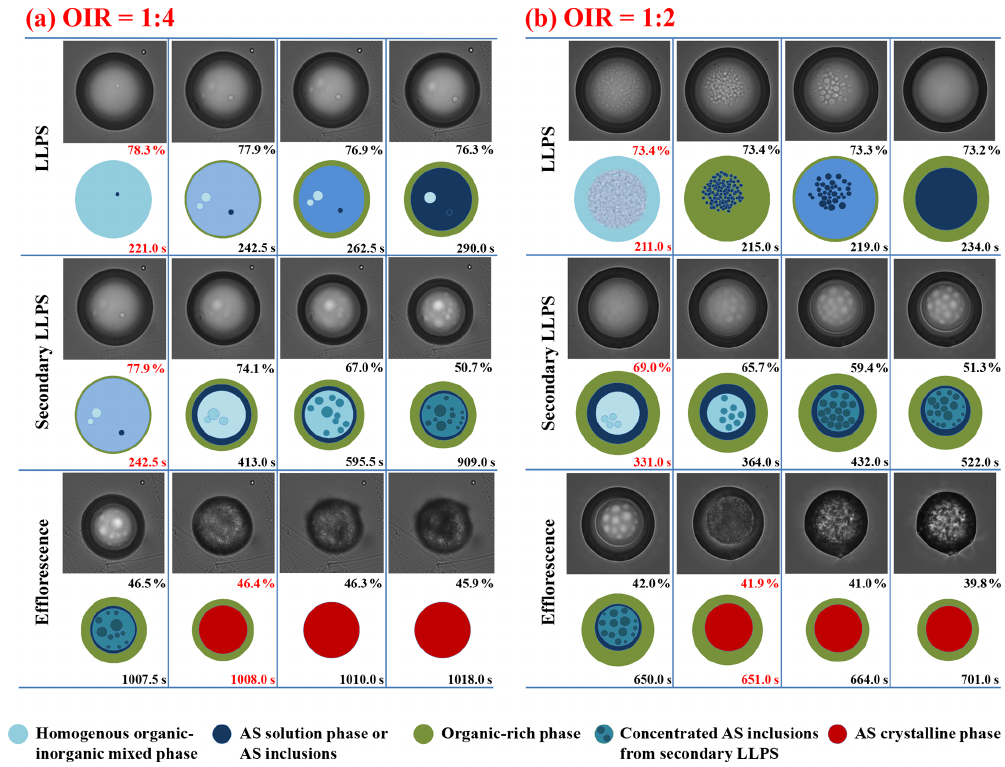
Figure 5. Optical images and corresponding illustrations of mixed 1, 2, 6-hexanetriol / AS particles with OIR = 1 : 4 (a) and 1 : 2 (b) during LLPS, secondary LLPS and efflorescence. Below the optical images are the illustrations. The corresponding RH and time are given in each frame. The RH and time in red indicate the occurrence of phase